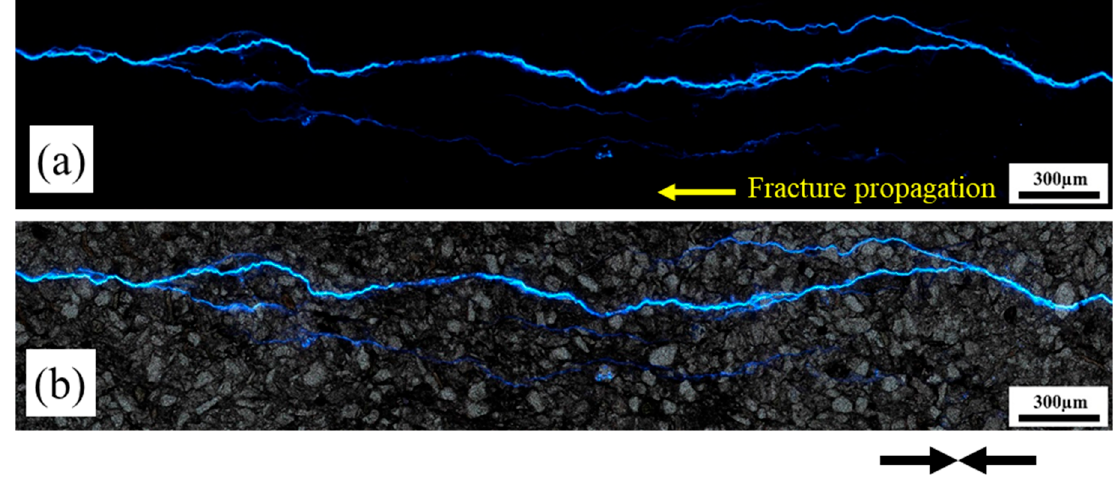
Figure 3. Microscopic observation of hydraulically induced fractures within the Inai shale specimen ( a ) under UV light and ( b ) under a single nicol with UV light. Bluish-white parts correspond to induced fractures. The fracture propagation direction is from right to left (yellow arrow). The pair of black arrows under ( b ) represents the loading direction.